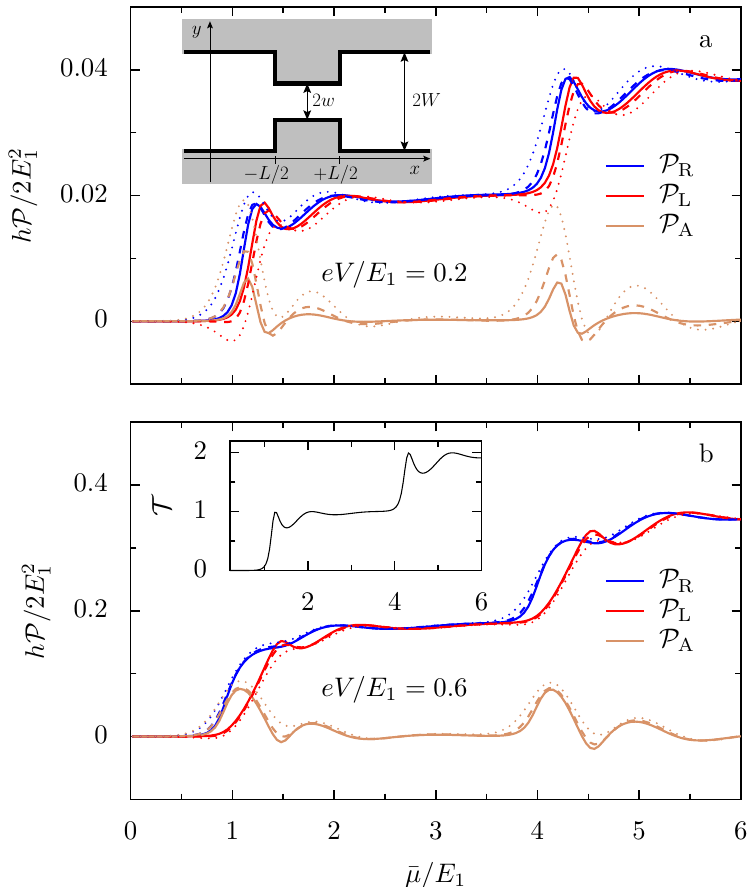
Figure 2: Dissipated power as a function of the mean electrochemical potential ¯ µ at the right ( , blue) and left ( , red) of an abrupt constriction (sketched in the inset P R P L of panel a), together with their difference ( , ocher) for low bias voltages, progres- P A sively departing from the linear regime [ (a) and (b) ] . Solid lines are for zero tem- = 0.04 T / E perature, dashed and dotted lines are results for temperatures with k B 1 and 0.08, respectively. The chosen energy scale E corresponds to that of the first 1 transverse mode in the narrow part, which for a QPC in a GaAs / AlGaAs heterostruc- ≈ 5.6eVnm 2 / ( 2 w ) 2 . Inset of panel b: transmission coefficient ture is given by E 1